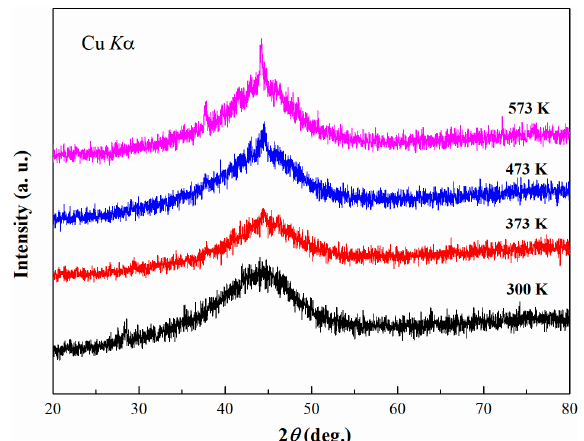
Figure 4. XRD patterns of Co 55 Ta 10 B 35 coating prepared by laser cladding at different substrate temperatures.